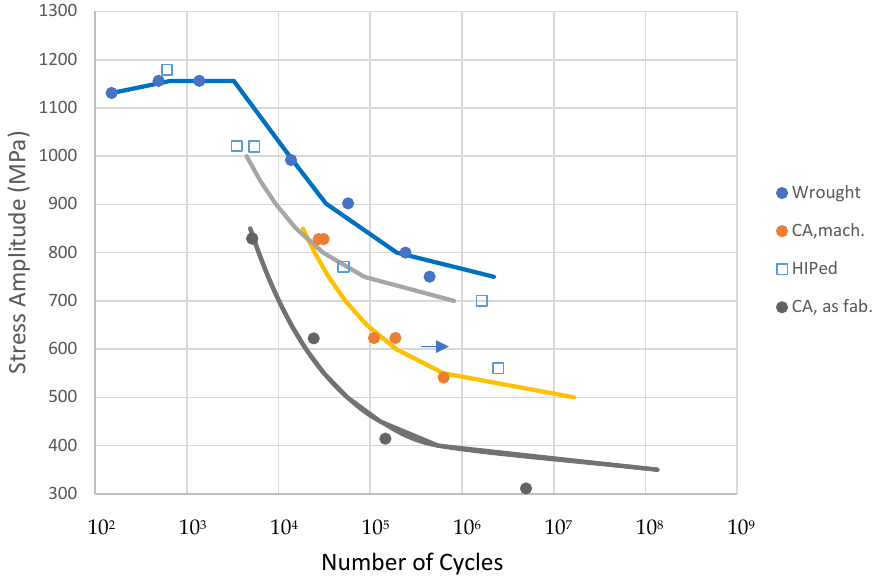
Figure 4. The TMW model-calculated fatigue life in comparison with the experimental data (arrow indicates runout) for 17-4 PH stainless steel. It can be inferred from Table 6 results that the surface roughness in the range from 0.01 μm to 9 μm only causes about a factor of 3 variations in fatigue life. Normally, the